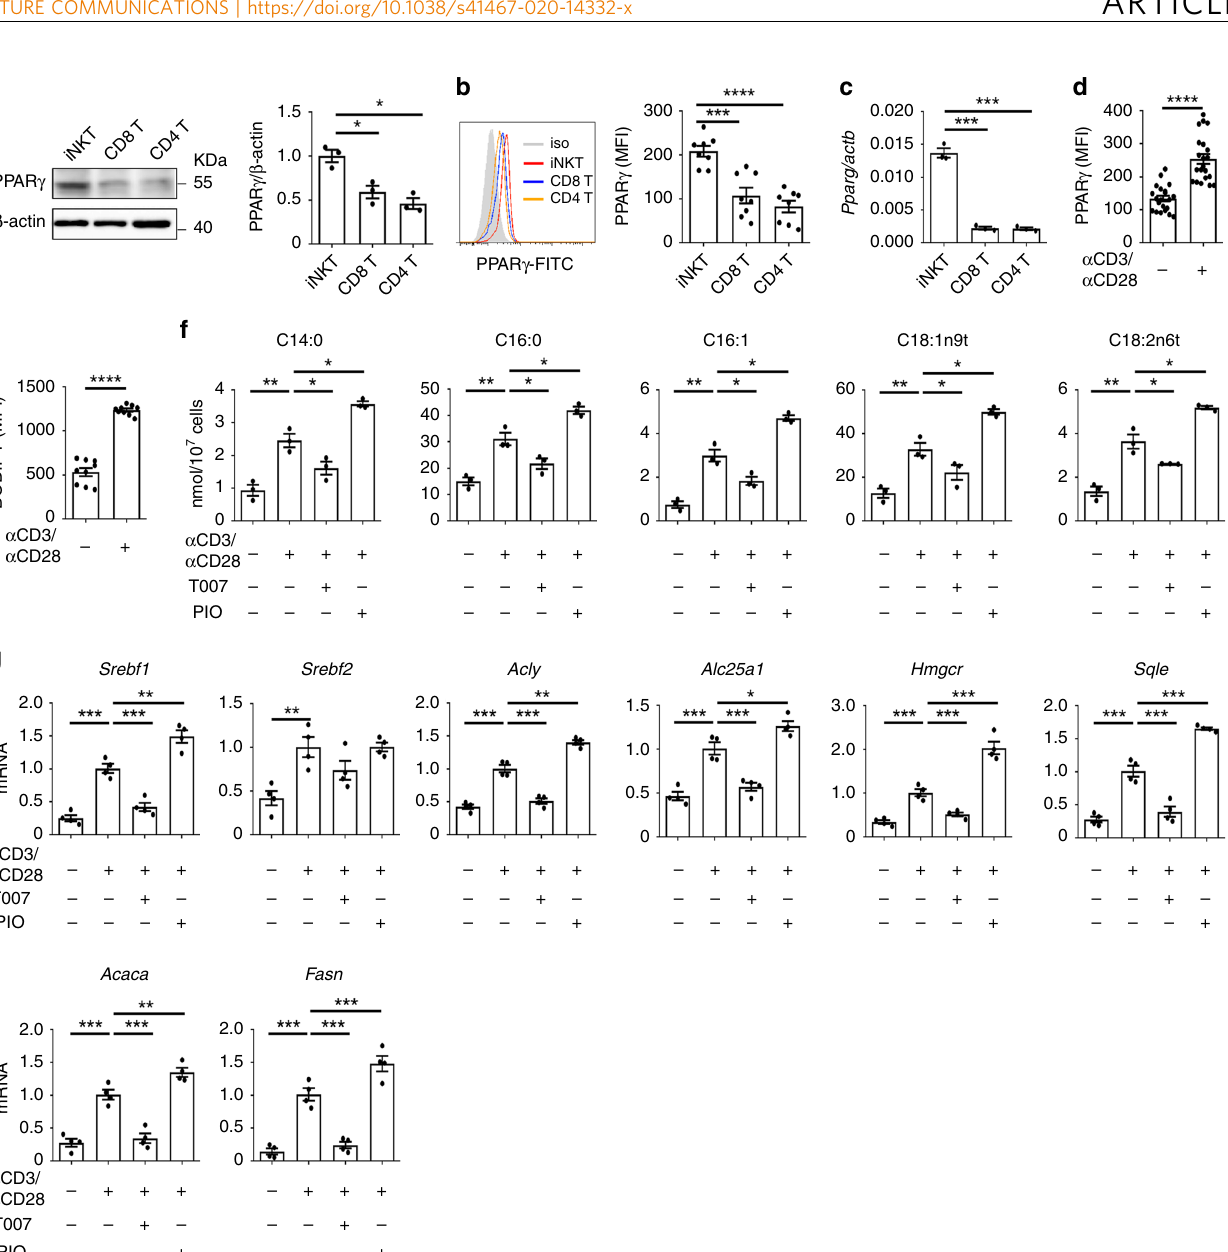
Fig. 1 PPAR γ promotes lipid biosynthesis in activated iNKT cells. a Expression of PPAR γ in iNKT, CD4 + T, and CD8 + T cells. b , c PPAR γ expression measured by fl ow cytometry ( b ) and mRNA of Pparg ( c ) in iNKT, CD4 + T, and CD8 + T cells from livers. d , e Flow cytometry analysis of PPAR γ expression ( d ) and lipids amount indicated by BODIPY staining ( e ) in iNKT cells unstimulated or stimulated with plate-coated anti-CD3 and anti-CD28 overnight. f Quanti fi cation of long-chain fatty acids in iNKT cells, 24 h after activation in vitro with or without T007, PIO. g mRNA of genes regulating lipid synthesis in iNKT cells activated by plate-coated anti-CD3 and anti-CD28 for 24 h with or without T007, PIO. Data are representative of three independent experiments ( a , b ), or are means ± SEM of three independent experiments ( a , c , f ), four independent experiments ( g ), 8 mice ( b ), nine biological replicates ( e ), or twenty biological replicates ( d ), pooled from three to four independent experiments. Data were analyzed by Mann – Whitney test ( a – c , f , g ) or unpaired Student ’ s t -test ( d , e ). * P < 0.05, ** P < 0.01, **** P < 0.0001. Source data are provided as a Source Data fi